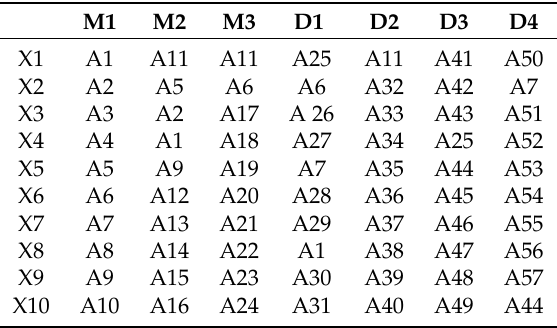
Table 3. Top 10 variables selected by the seven models.